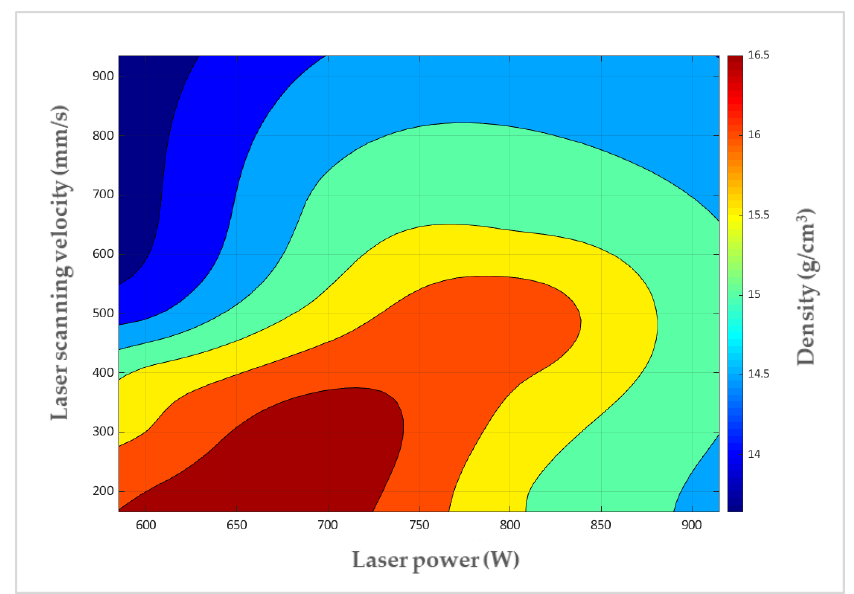
Figure 8. Diagram of the W-5Ni-2Fe samples density, prepared by the SLM method, depending on laser power and laser scanning velocity.